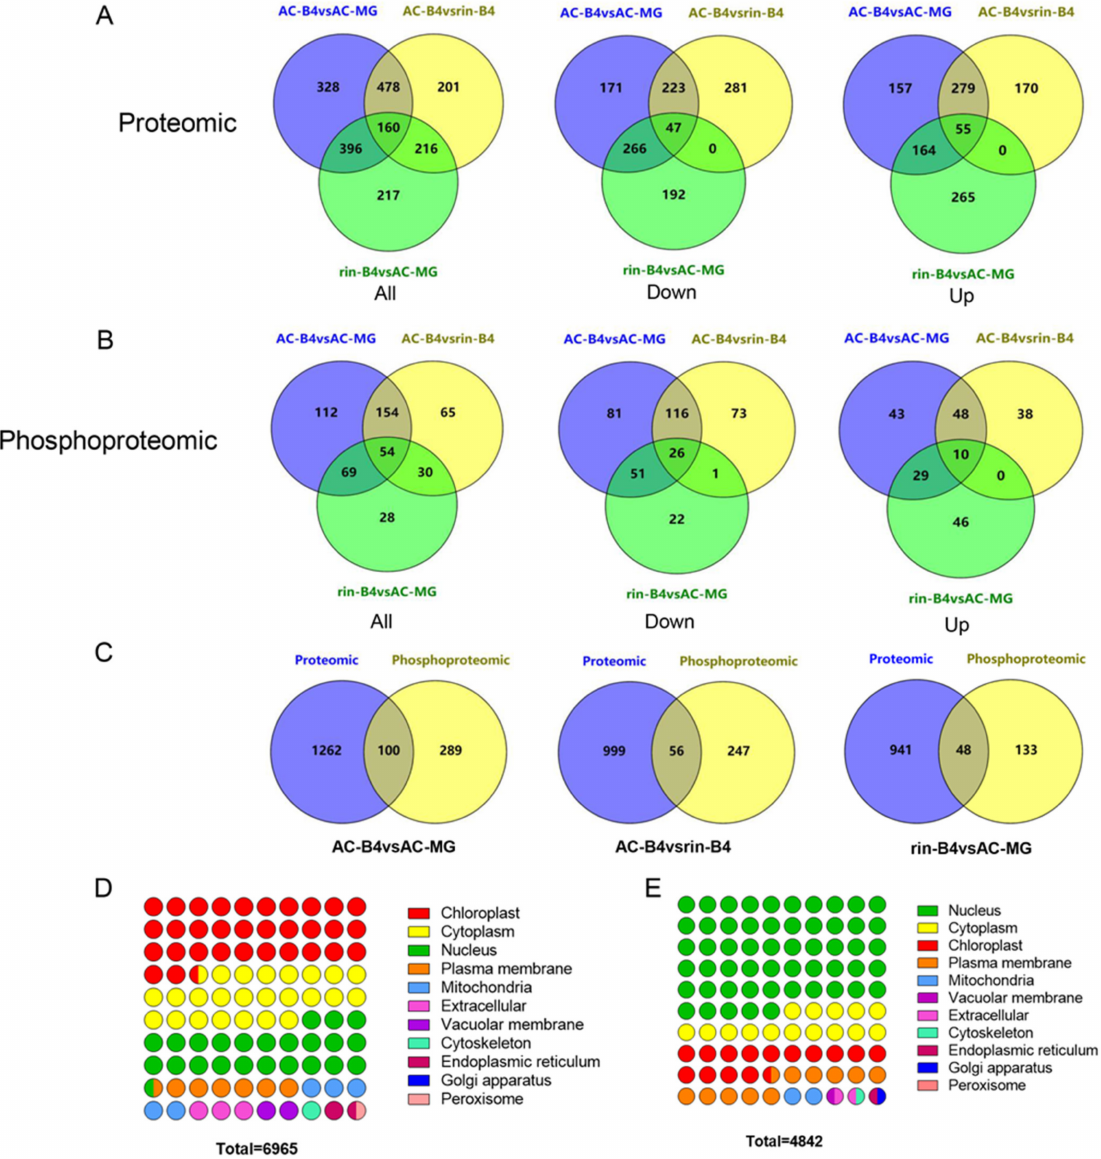
Figure 2. The overlap and subcellular localization of the differentially expressed proteins and phosphoproteins. Overlap of the differentially expressed proteins (DEPs) and phosphoproteins (DEPPs) in Venn diagrams with different comparisons. ( A ) DEPs; ( B ) DEPPs; ( C ) DEPs and DEPPs of two omics. The subcellular localization of the fruit proteome protein ( D ) and phosphoproteins ( E ) predicated by GO